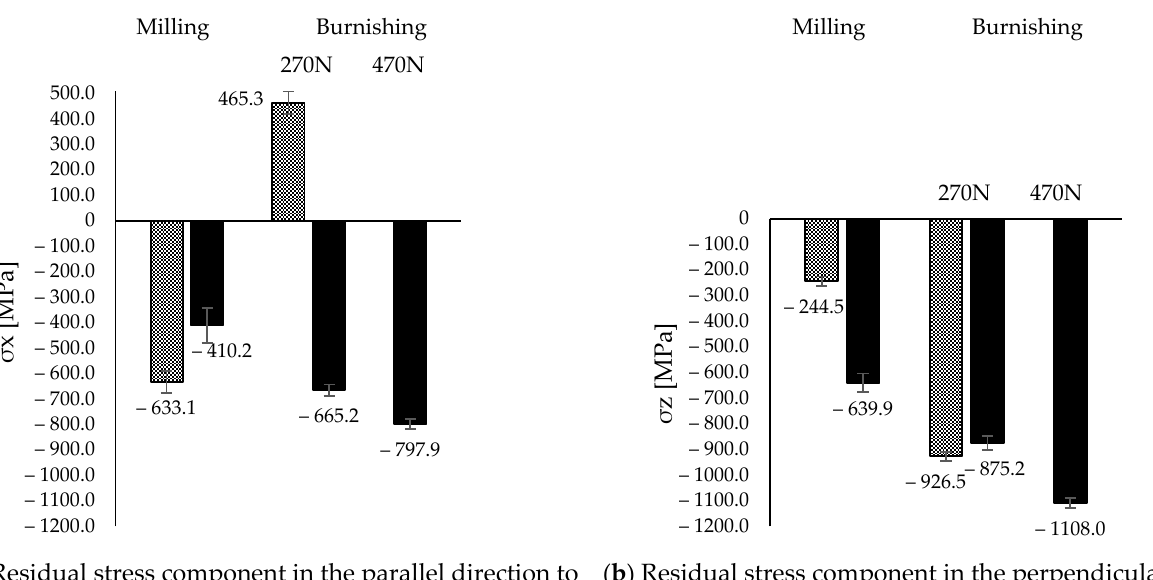
Figure 7. Residual tensor after milling and burnishing processes on stainless steel surfaces.